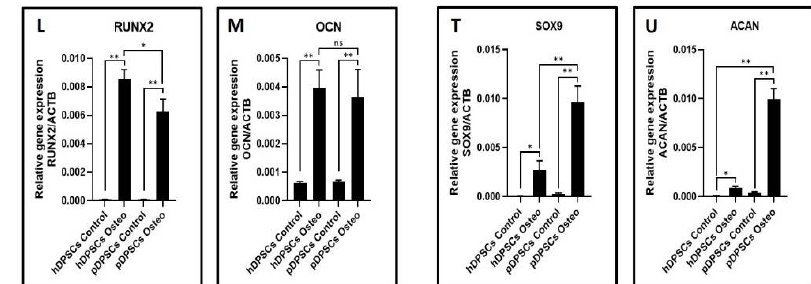
Figure 6. Assessment of migration, osteogenic differentiation and chondrogenic differentiation in DPSCs from healthy and periodontitis-affected teeth after cryopreservation. ( A – E ) comparative analysis of the migratory ability of hDPSCs and pDPSCs. ( F – I ) comparative analysis of osteogenic differentiation in hDPSCs and pDPSCs. ( J , K ) comparative analysis of mineralization in osteogenically induced hDPSCs and pDPSCs at day 7 and day 21. ( L , M ) comparative analysis of osteogenesis-related genes RUNX2 and OCN in osteogenically induced hDPSCs and pDPSCs at day 21. ( N – Q) comparative analysis of chondrogenic differentiation in hDPSCs and pDPSCs. ( R , S ) comparative analysis of GAG content in chondrogenically induced hDPSCs and pDPSCs at day 7 and day 21. ( T , U ) comparative analysis of chondrogenesis-related genes SOX9 and ACAN in chondrogenically induced hDPSCs and pDPSCs at day 21. Experiments were repeated in triplicates for n = 3. ns: not significant, * p < 0.05 and ** p < 0.01. hDPSCs: dental pulp stem cells from healthy teeth, pDPSCs: dental pulp stem cells from periodontitis-affected teeth, Osteo: osteogenic induction, RUNX2 : Runt-related transcription factor 2, OCN : osteocalcin, Chondro: chondrogenic induction, GAG: glycosaminoglycan, SOX9 : SRY-box transcription factor 9 and ACAN : aggrecan.